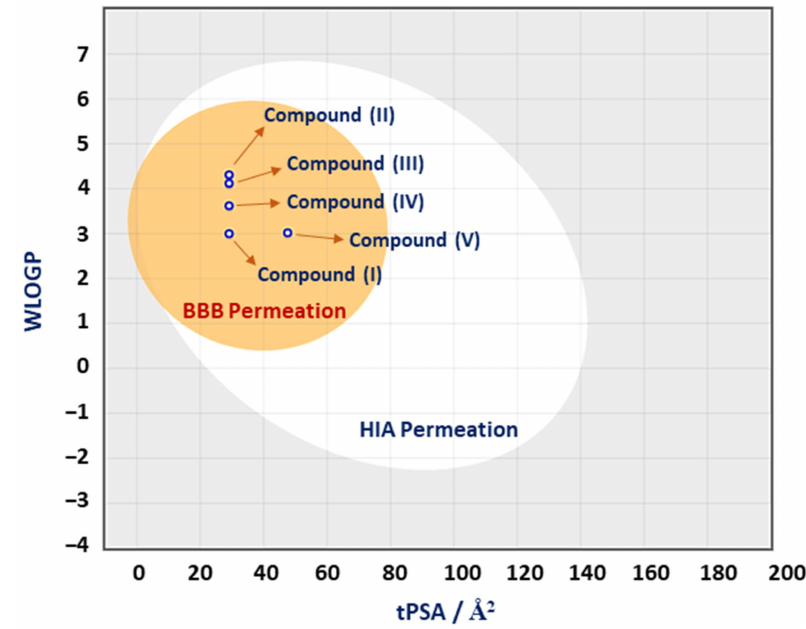
Figure 11. BOILED-Egg predictive model for the compounds ( I – V